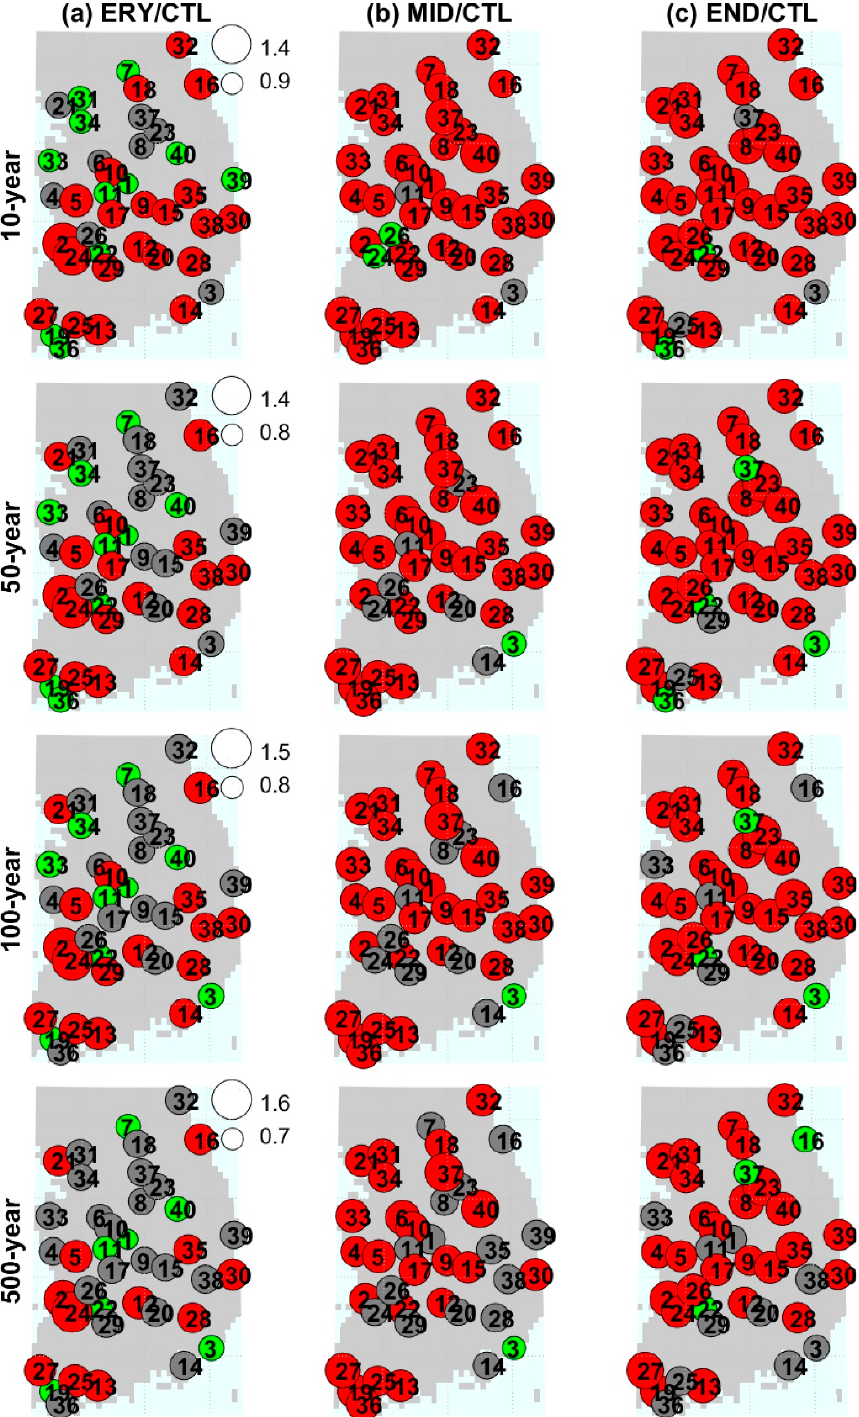
Figure 5. Spatial map of FOC of rainfall frequency estimates at 1-h duration over South Korea for RCP 8.5. The circle size of each location represents the magnitude of FOC. The number near the white circles are used as legends to indicate the relative magnitudes of circles size. A test of significance, t -test is applied to 2 distributions of rainfall frequency estimates in the future and control periods for each location. The dark grey color means that there is no difference between 2 distributions, while red color refers that those increase, and green color refers that those decrease in the future.